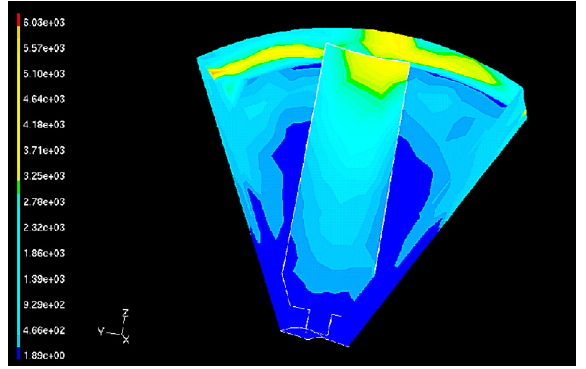
Figure 16: Dynamic pressure on the pressure side and top face of the domain without radiator (unit in Pascal).